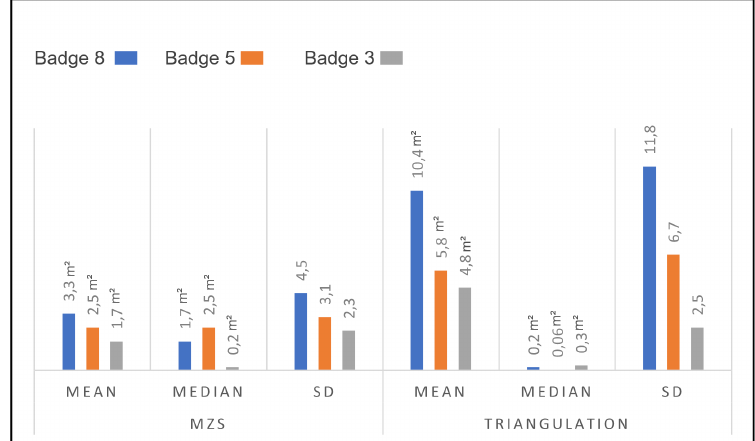
Figure 10. Properties of areas computed by both